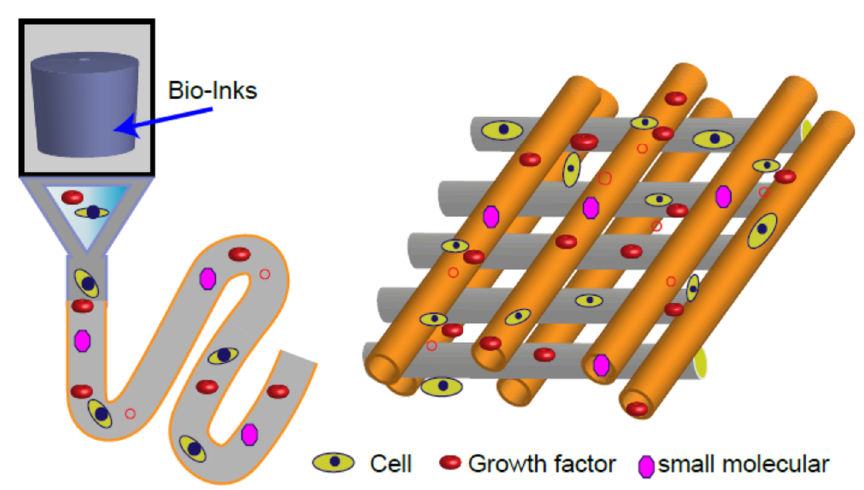
Figure 2. Schematic summary of various bioinks for 3D bioprinting of biomaterials.